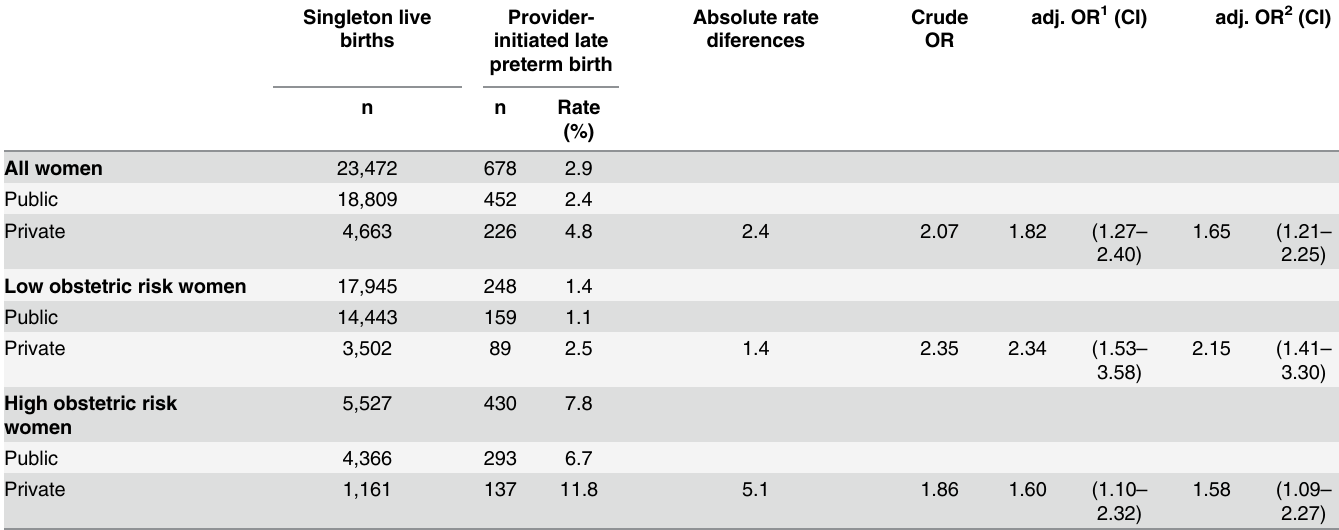
Table 4. Private childbirth care associated with provider-initiated late preterm rate (%) in singleton live births. Birth in Brazil, 2011 –